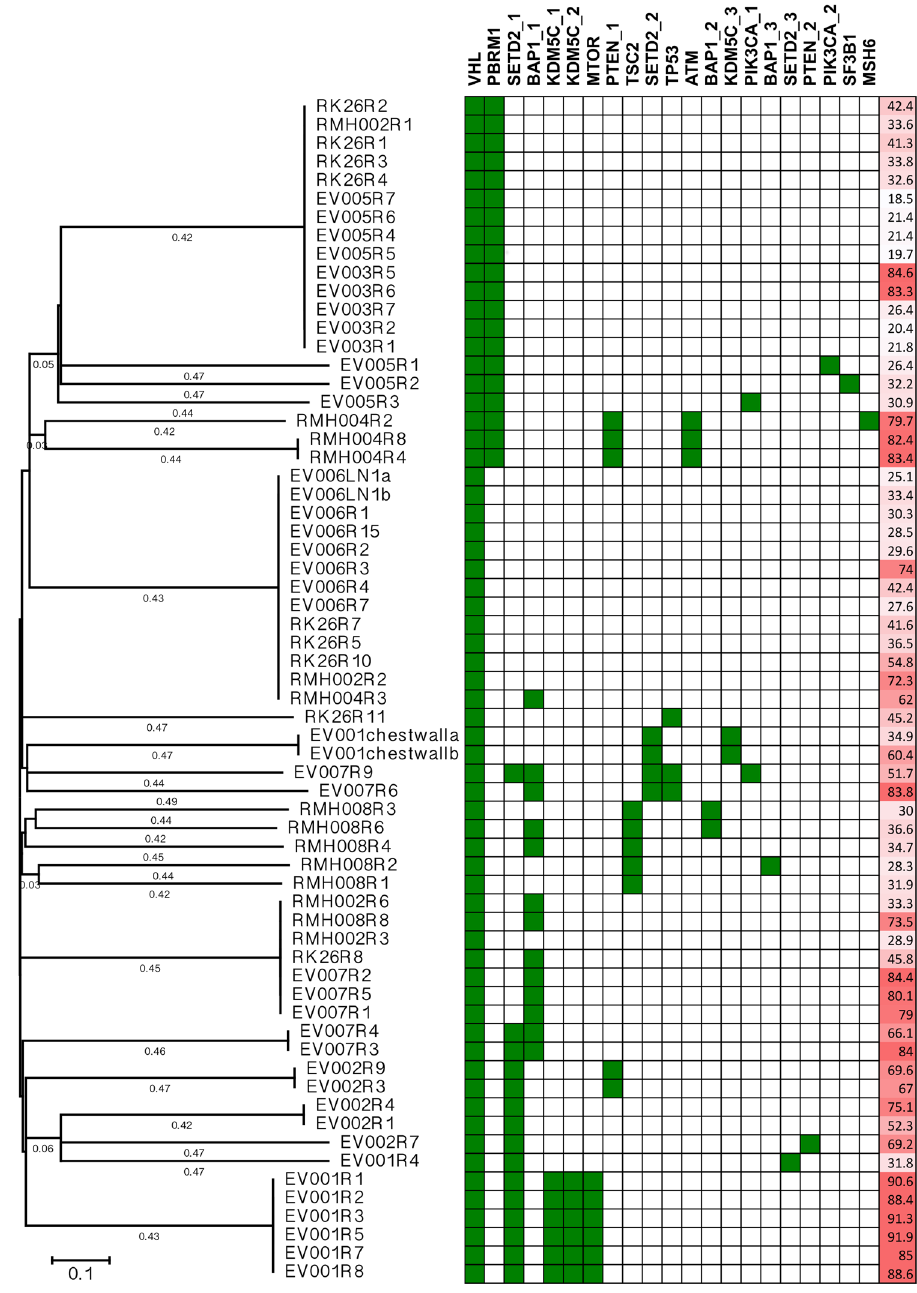
Figure 5. Phylogenetic tree with driver mutation status and CLEAR score. The region tree provides the information of the connection of sample diversity, prognosis and the driver gene mutation. The region tree shows majority of sample regions are clustered together with their siblings with several exceptions caused by intra-tumor heterogeneity and PBRM1 is associated with regions with low prognosis score, while SETD2, BAP1 and KDM5C are associated with the poor prognosis sample